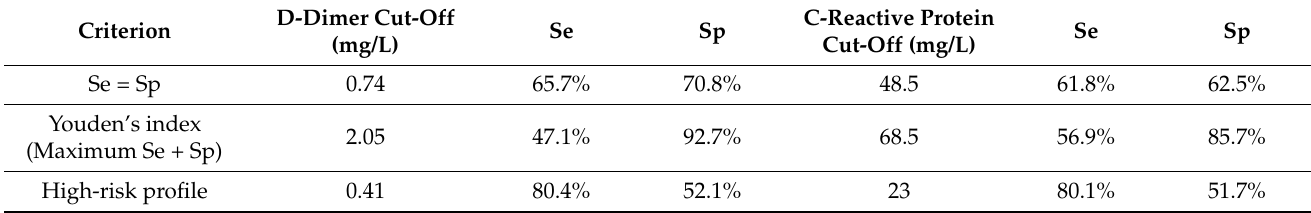
Table 8. Cut-off values for D-Dimer and C-reactive